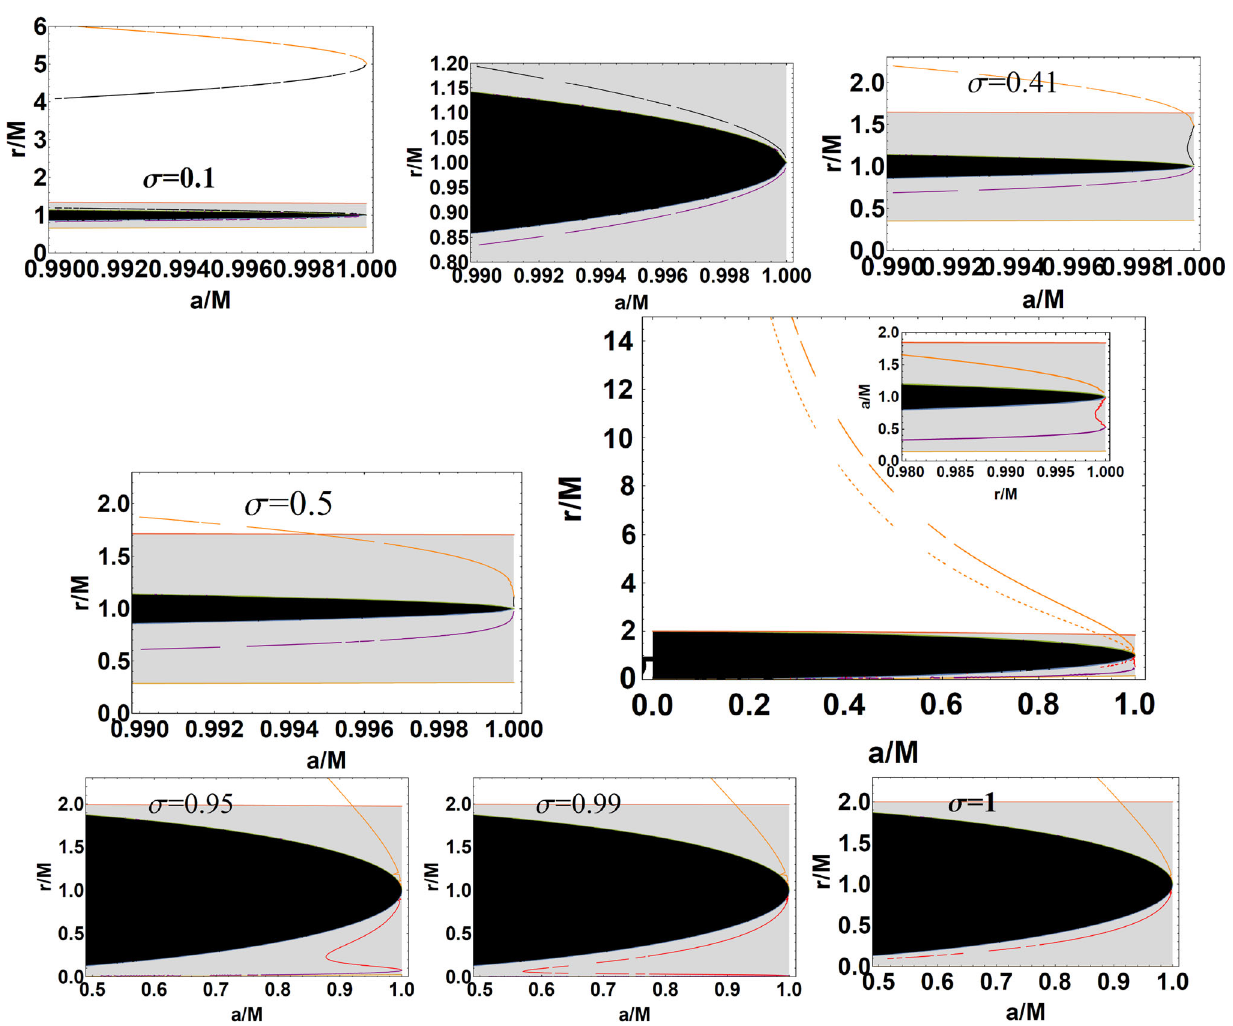
ω + = ω + ( r + ) purple curve. The black region is a BH on the extended plane r ∈ [ r − , r + ] , the gray region is the